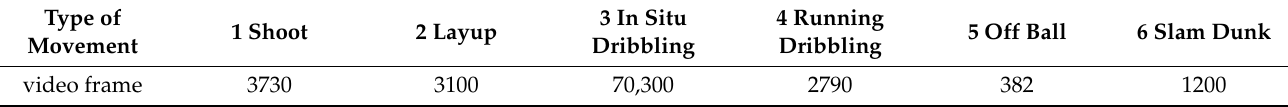
Table 3. Action classification and video frame number